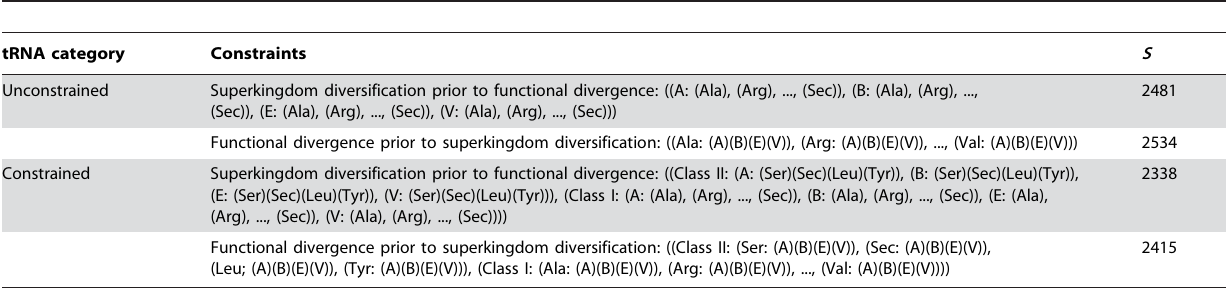
Table 3. The numbers of additional steps ( S ) required to force molecules into monophyly based on tRNA category, amino acid specificity, and organismal constraints using MP analyses of combined tRNA structure and sequence data